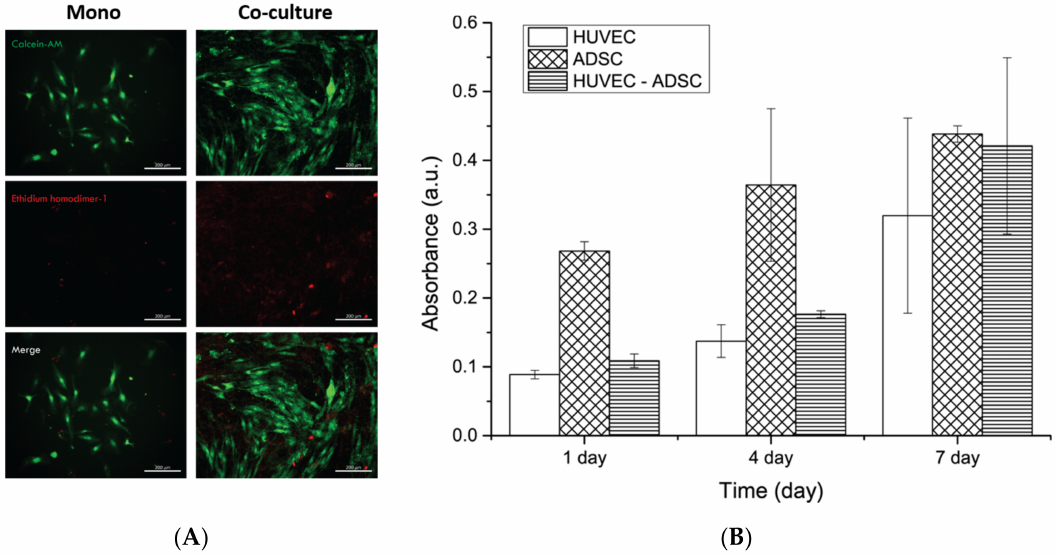
Figure 3. Viability and proliferation assays of monoculture and co-culture of HUVECs and ADSCs on the nanofibrous PCL/gelatin scaffolds. ( A ) Representative LIVE/DEAD fluorescence image of HUVECs and ADSCs in the co-culture system at seven days after culture. Scale bars represent 200 µ m; ( B ) Cell proliferation assay of each group of cells (HUVECs only, ADSCs only, and co-cultured cells) cultured on PCL/gelatin nanofiber scaffolds. The CCK-8 assay was examined at one, four, and seven days of culture to identify the cell proliferation according to the absorbance at 450